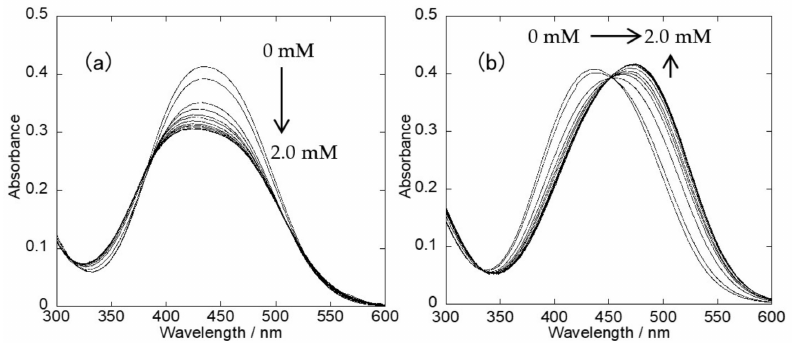
Figure 2. Changes in UV-Vis spectra of 1-Zn in the ( a ) absence or ( b ) presence of 3-NH 2 - γ -CyD with increasing concentrations of ATP. [ 1-Zn ] = 0.020 mM, [HEPES] = 5.0 mM; [3-NH 2 - γ -CyD] = 2.0 mM; [ATP] = 0, 0.020, 0.20, 0.40, 0.60, 0.80, 1.0, 1.2, 1.4, 1.6, 1.8, 2.0 mM, in 1% DMSO aq. at pH 7.4.